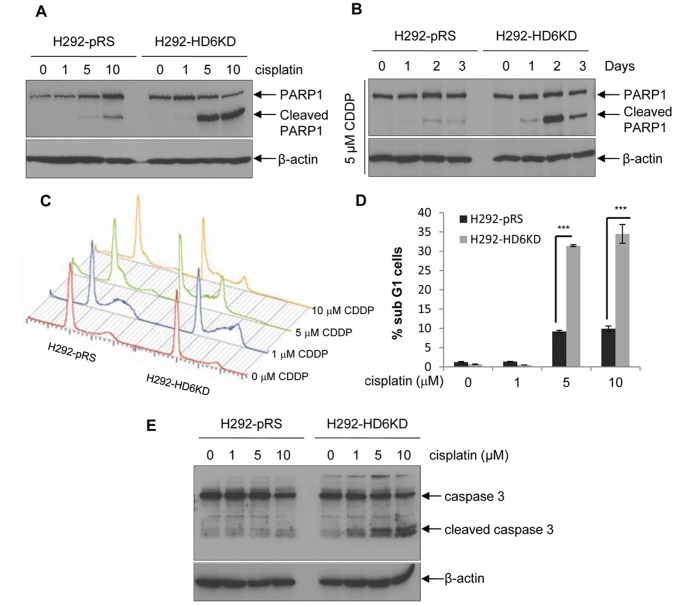
Depletion of HDAC6 augments cisplatin-induced apoptosis in H292 cells. A, H292-pRS or H292-HD6KD cells were treated with indicated concentrations of cisplatin for 24 hours. Anti-PARP1 and anti-β-actin Western blotting analyses were carried out. B, H292-pRS and H292-HD6KD cells were treated with 5 µM cisplatin for the indicated days. Anti-PARP1 and anti-β-actin Western blotting analyses were performed. C, Sub-G1 population was determined in H292-pRS or H292-HD6KD cells treated with vehicle (0 µM cisplatin) or cisplatin by FACS analysis. CDDP represents cisplatin. D, Quantitative presentation of the percentages of sub-G1 phase cells from C. E, H292-pRS or H292-HD6KD cells were treated with indicated dosage of cisplatin, and anti-cleaved caspase 3 and anti-β-actin Western blotting analyses were performed.